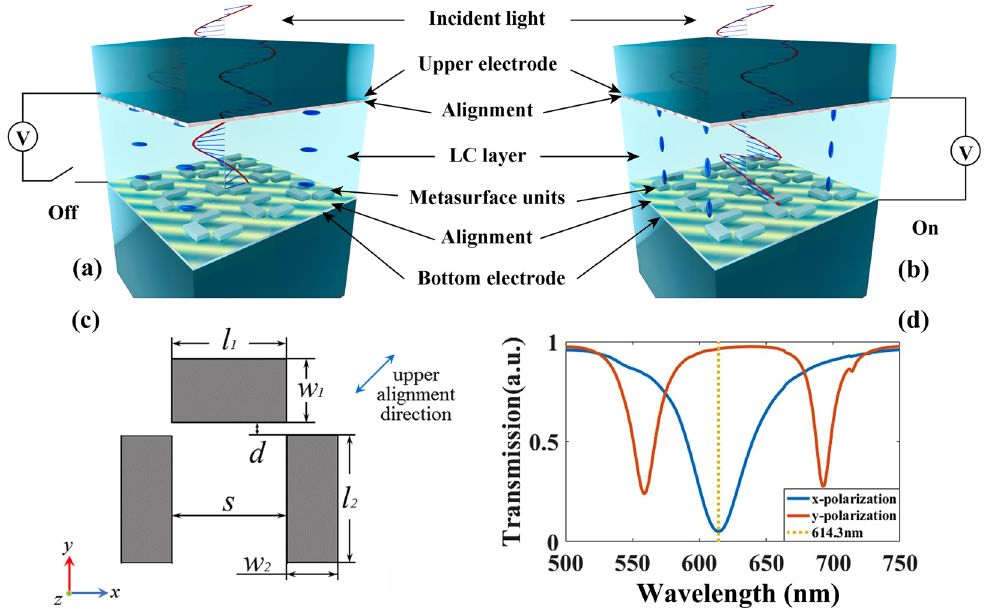
Figure 1. Schematic diagram for the EIT metasurface and LC sections at ( a ) the “off” state and ( b ) the “on” state. ( c ) Planar structural representation of a metasurface unit. ( d ) Numerical result of the metasurface responses under the x- and y-polarized incident light without the LC